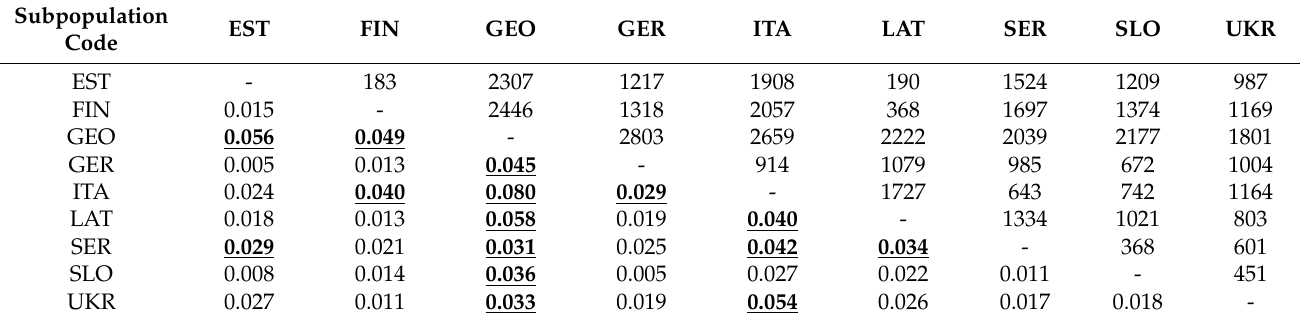
Table 5. Nei’s genetic and geographical distances for subpopulations with a clone corrected sample size ≥ 6. Below the diagonal are Nei’s genetic distances and above are geographical distances (km). Genetic differences higher than the arithmetic average value (0.028) are given in bold and